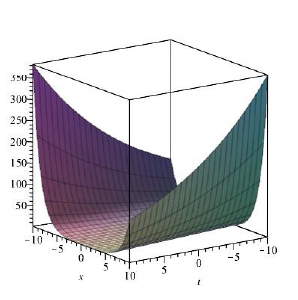
Figure 1. 3D plot of u ( x,t ) of solution (3.12) by considering